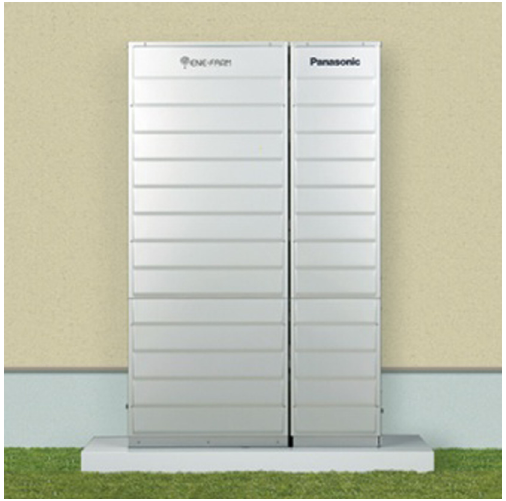
Fig. 1. Photo of a PEFC system.